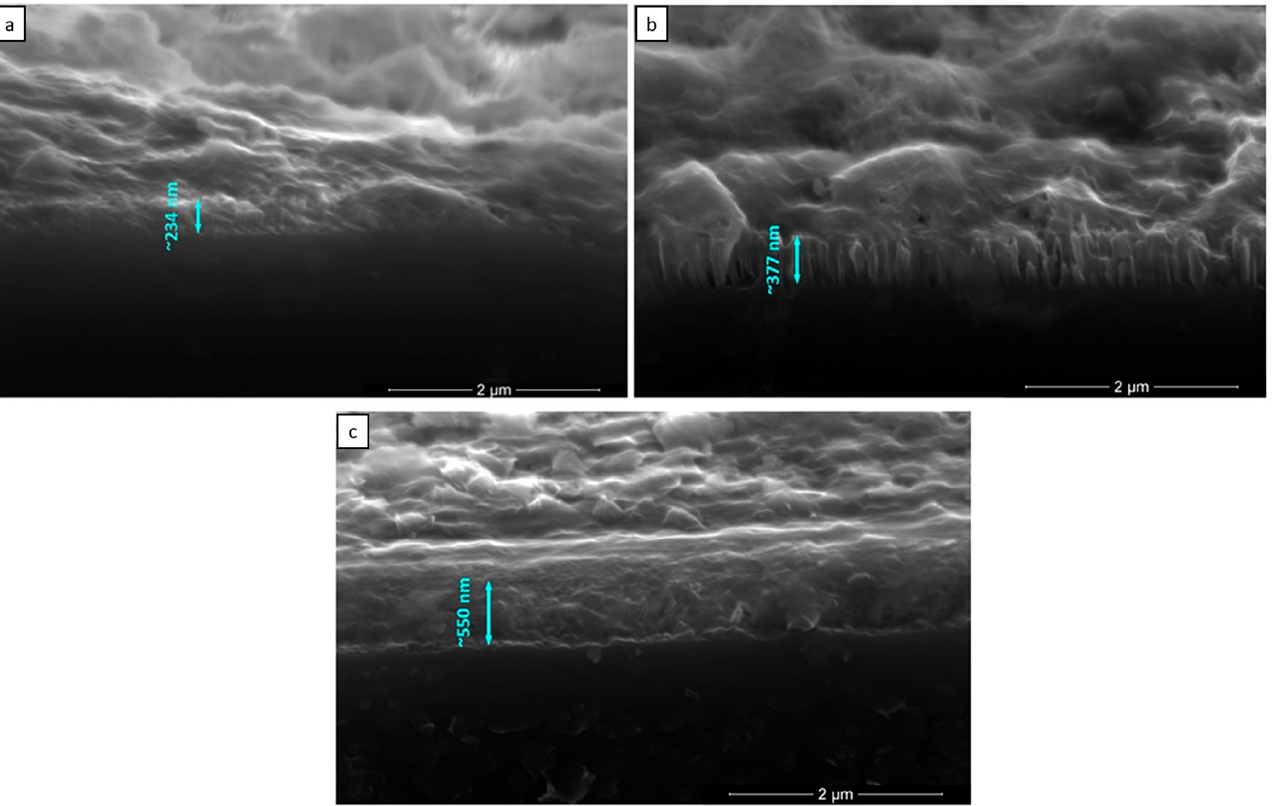
Figure 10. SEM image of the silicon wafer with a perovskite layer obtained in a two-step deposition process with wires etched by MAE for: ( a ) 10 s, ( b ) 20 s, ( c ) 30 s (13.00 kV, mag. 50,000×).